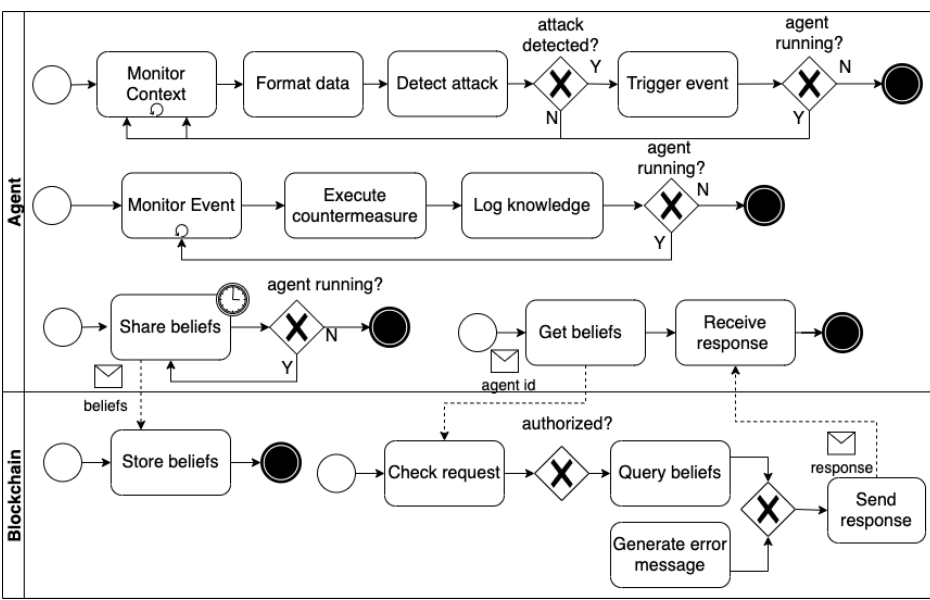
Figure 7. The abstract security adaptation